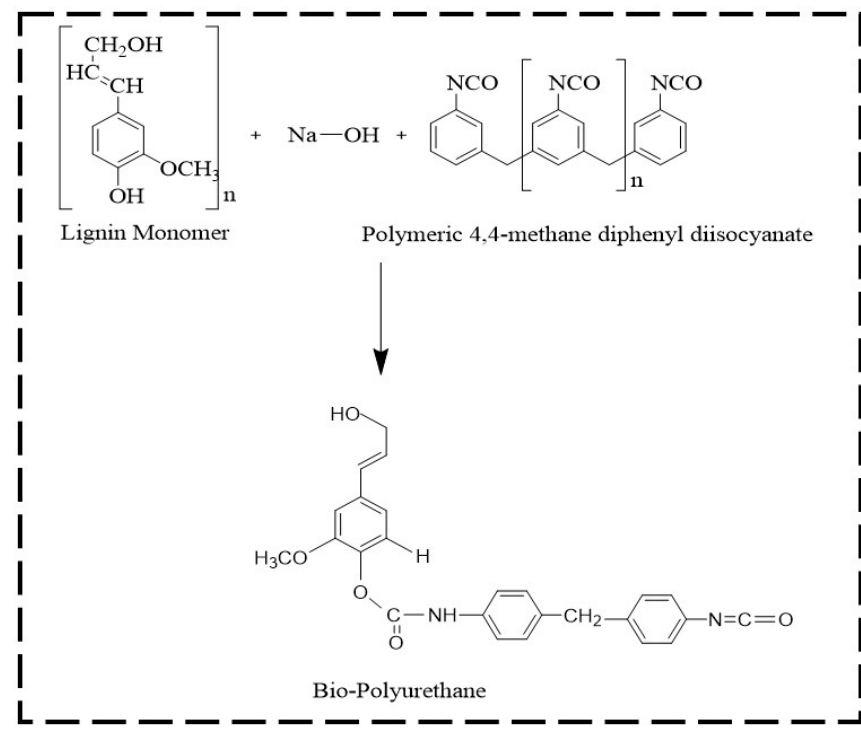
Figure 2. The possible reaction scheme of lignin ‐ based Bio ‐ PU